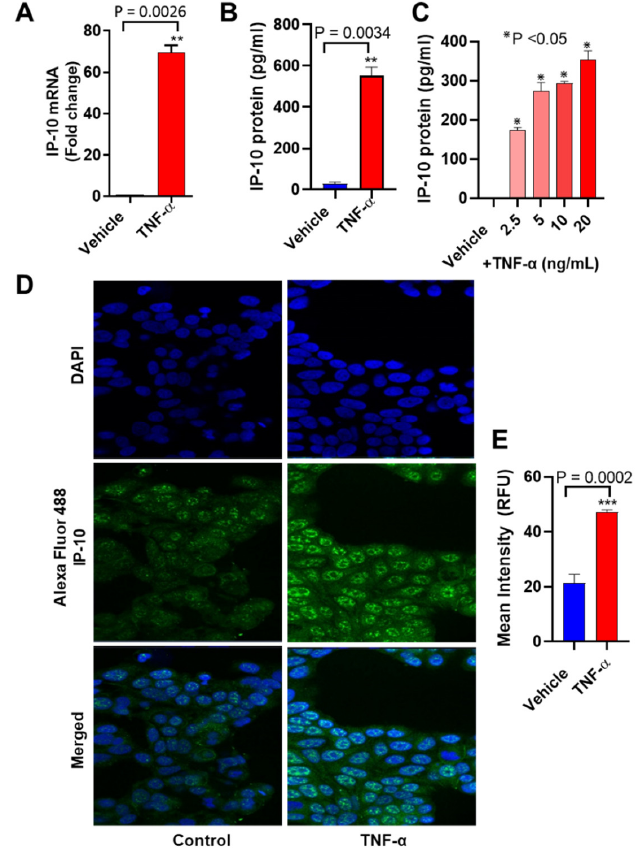
Figure 1. Effect of TNF-α on IP-10 production in human MCF-7 cells. MCF-7 cells were cultured in 12-well plates at a concentration of 0.25 × 10 6 cells/well. Cells were treated separately with vehicle and TNF-α (20 ng/mL) for 24 h. After 24 h incubation, cells and supernatants were collected. ( A ) Total cellular RNA was isolated, and IP-10 mRNA expression was determined by real-time RT-PCR. ( B ) Secreted IP-10 protein in culture media was determined by ELISA. ( C ) MCF-7 cells were treated with different concentrations of TNF-α (2.5, 5, 10, and 20 ng/mL) for 24 h, and protein expression of IP-10 was determined and compared in conditioned media. ( D ) MCF-7 cells treated with vehicle and TNF-α for 24 h were stained for confocal microscopy, as described in Materials and Methods. IP-10 expression is shown by green fluorescence (Alexa Flour 488), whereas nuclei are stained blue with DAPI (original magnification: 40×). ( E ) Relative fluorescence intensity of IP-10 was determined from random regions of the images. All data are expressed as mean ± SEM ( n = 3). * p < 0.05, ** p < 0.01, *** p < 0.001.